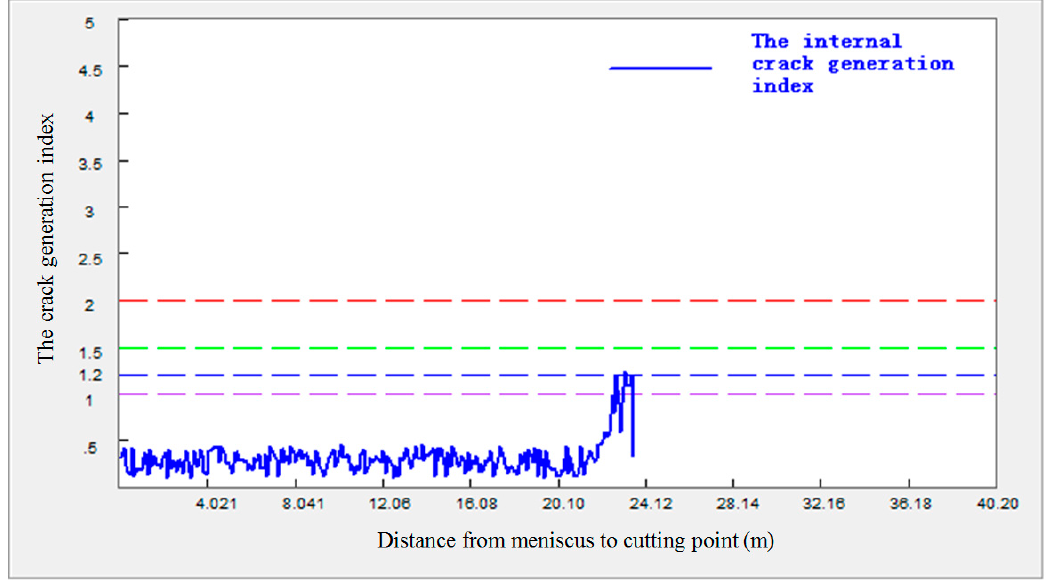
Figure 4. The internal crack generation index distribution at the beginning stage of casting.